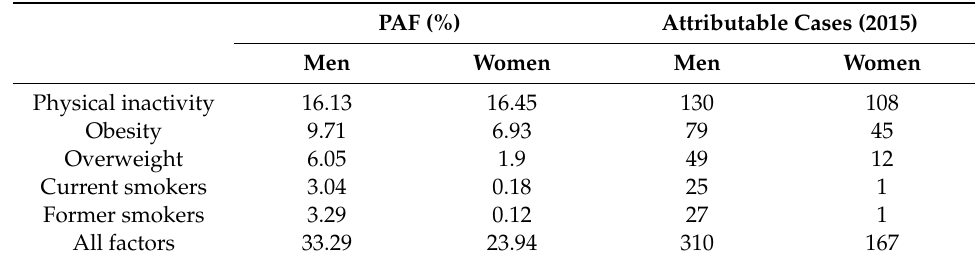
Table 2. Population attributable fractions (PAFs) and number of colorectal cancer (CRC) cases attributable to each risk factor in Saudi Arabia, 2015.